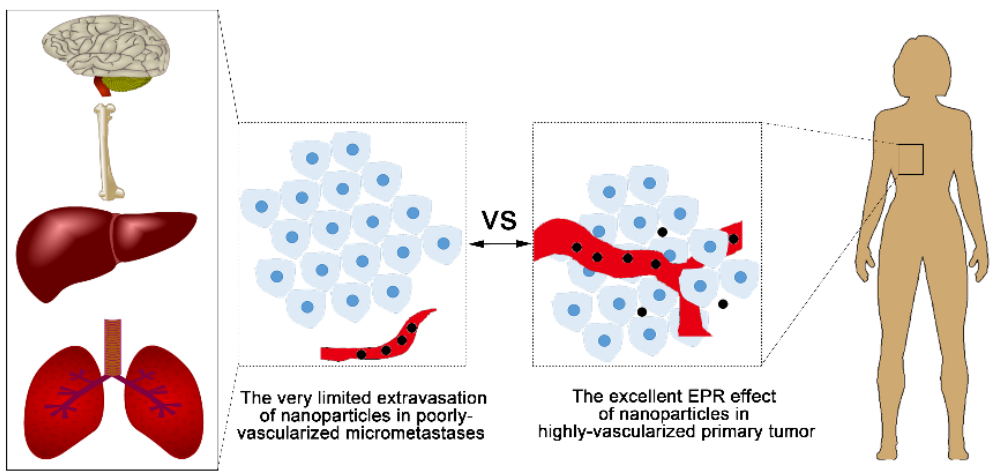
Figure 2. The limited Enhanced Permeation and Retention (EPR) effect in micrometastases. Nanoparticles circulating in the blood could accumulate in a large and well-vascularized primary tumor via EPR effects; in contrast, micrometastases are poorly vascularized and restrict the access of